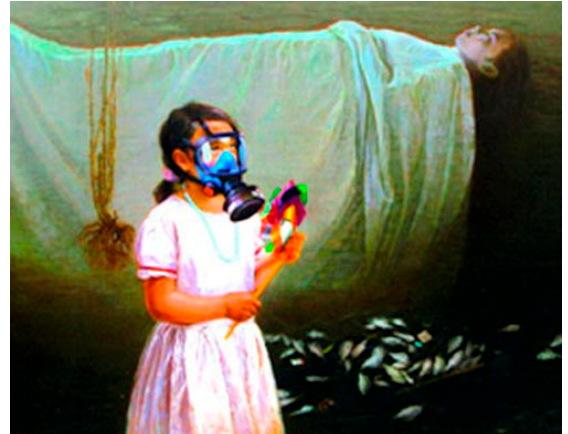
Figure A31. The painting Song chet (The dead river)—Le The Anh. Where the Bien chet plagiarized from. The image was sourced from VnExpress (Thanh 2017).